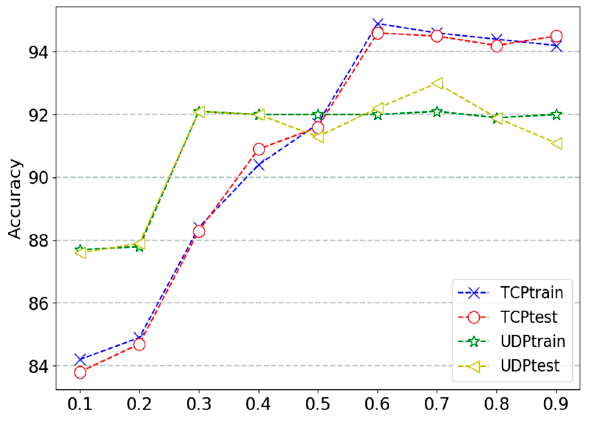
Figure 9. The abscissa is the value of ρ 0.